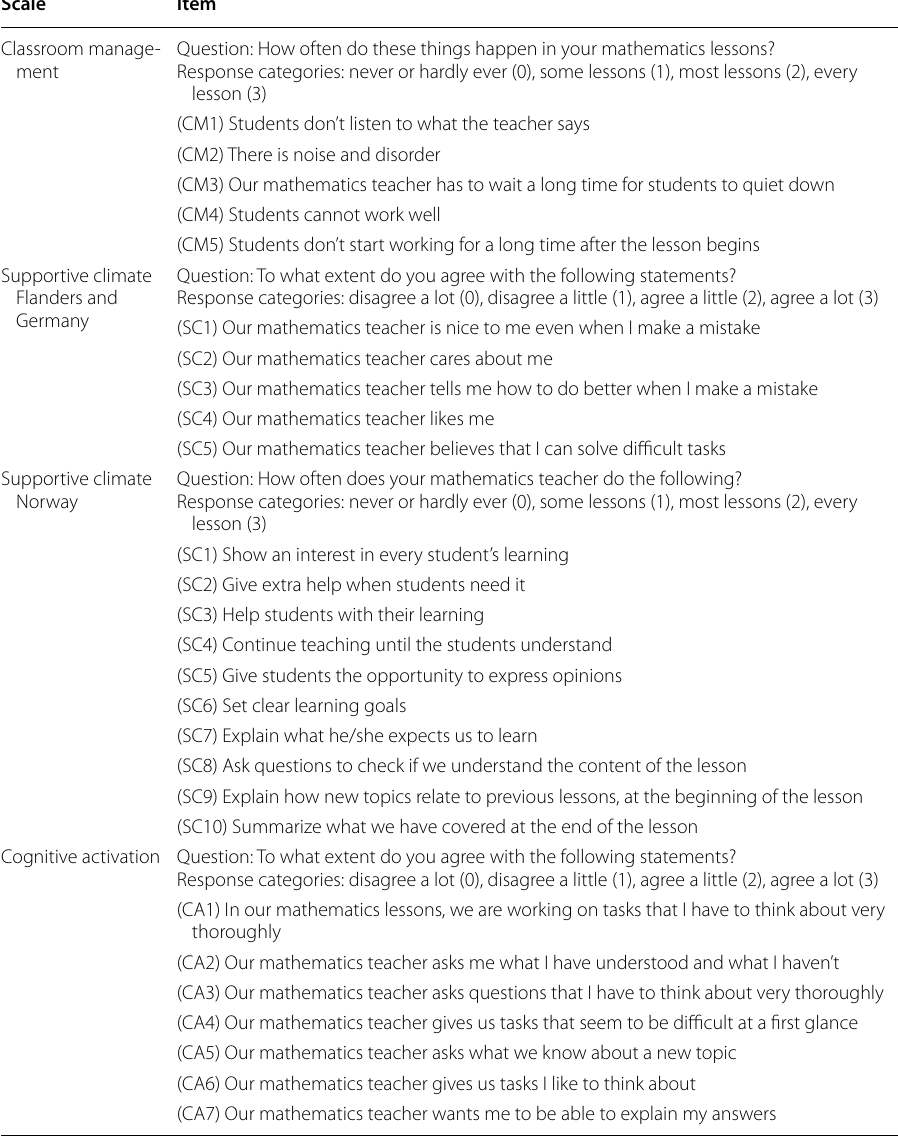
Table 9 Extra items on instructional quality in TIMSS